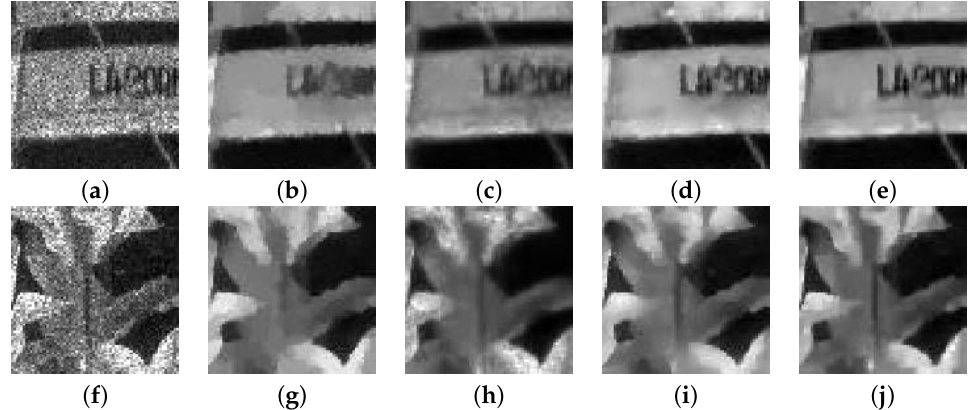
Figure 6. Zoomed-in region of Figure 5: ( a ) Degraded. ( b ) CONVEX. ( c ) OGSTVD. ( d ) M-TGV.